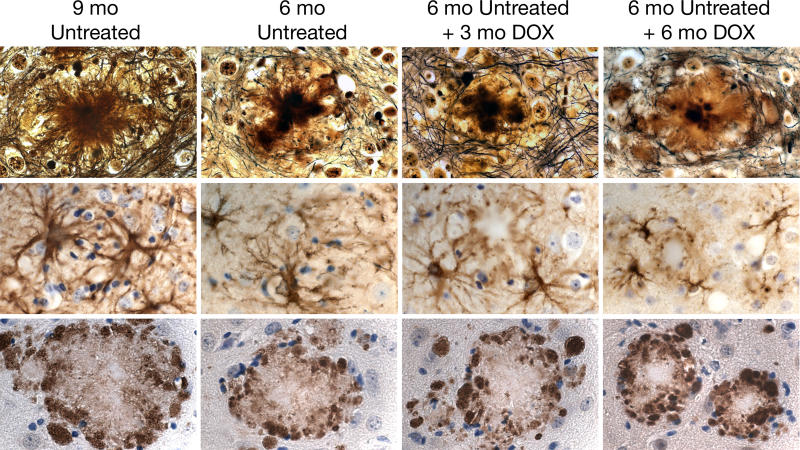
Neuritic and Glial Pathology Are Unchanged following Transgene SuppressionDystrophic neurites and activated astrocytes surround most compact plaques in tet-off APP mice (line 107). Dark-stained, ubiquitin-filled neurites and reactive astrocytes form a halo around cored, fibrillar deposits by 6 mo of age that worsens with time in untreated mice. Both plaque-associated pathologies are arrested, although not reversed, by transgene suppression. Hirano silver stain (top row); GFAP immunohistochemistry (middle row); ubiquitin immunohistochemistry (bottom row).